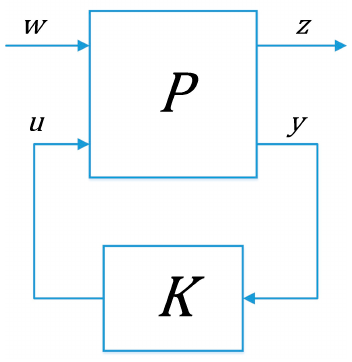
Figure 5. General closed-loop interconnection.